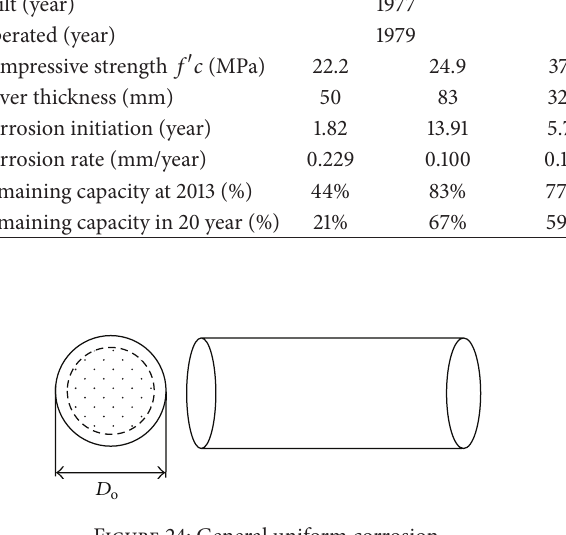
Figure 24: General uniform